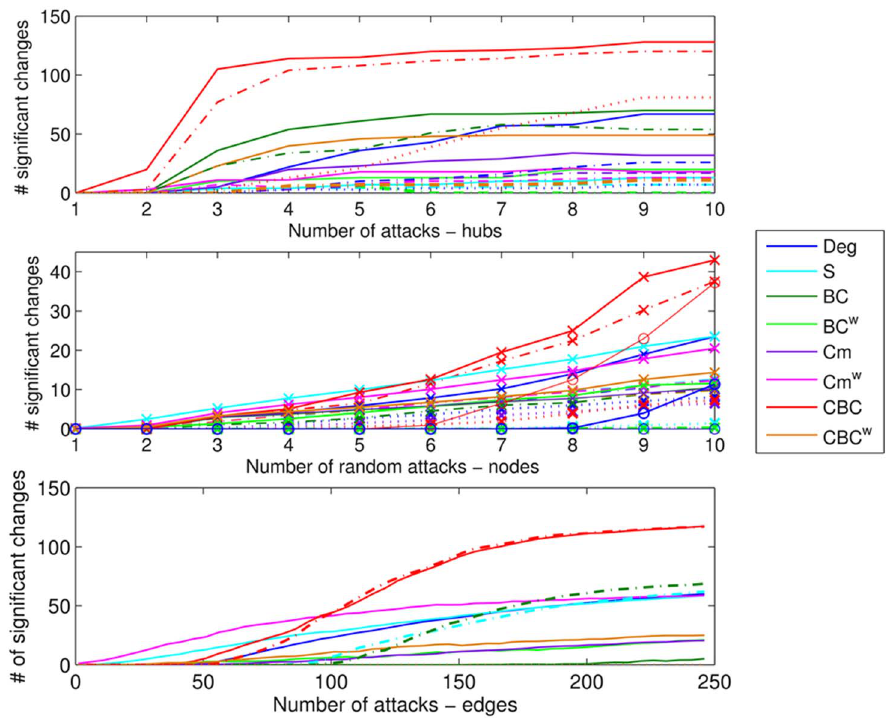
Fig. 4. Local changes due to simulated lesions. Top: number of significant local changes for the various metrics when hubs were targeted for binary lesions. The line types indicate the rate of deleted connections: solid lines R 5 0.8, dashed lines R 5 0.5 and dotted lines R 5 0.2. Center: average number of significant local changes over 25 repetitions for the various metrics when random nodes were targeted for binary lesions. The line types indicate the site selection and rate: solid lines with cross markers for same nodes for all subjects and rate R 5 0.8, dashed lines with cross markers for same nodes for all subjects and R 5 0.5, dotted lines for with cross markers for same nodes for all subjects and R 5 0.2 and solid lines with circle markers different nodes for each subject R 5 0.8. Bottom: average number of significant local changes over 25 repetitions for the various metrics when edges were targeted for binary lesions. The line types indicate if the same edges (solid lines) or different edges (dashed lines) were selected for each subject.